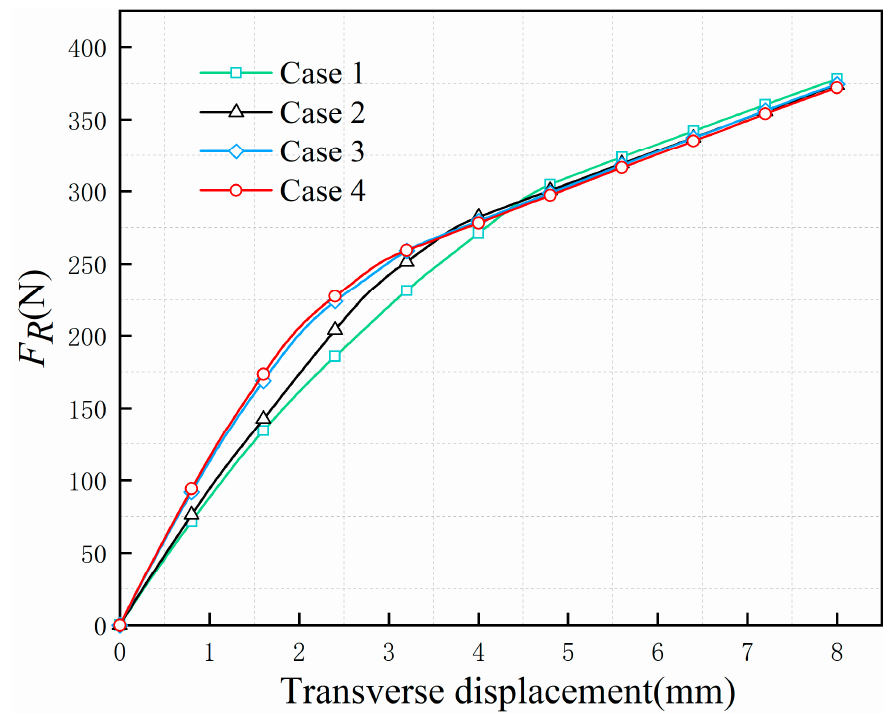
Figure 6. Reaction force–displacement curves of four solid FEM models with different mesh densities. Table 3. Analysis cases for each mesh